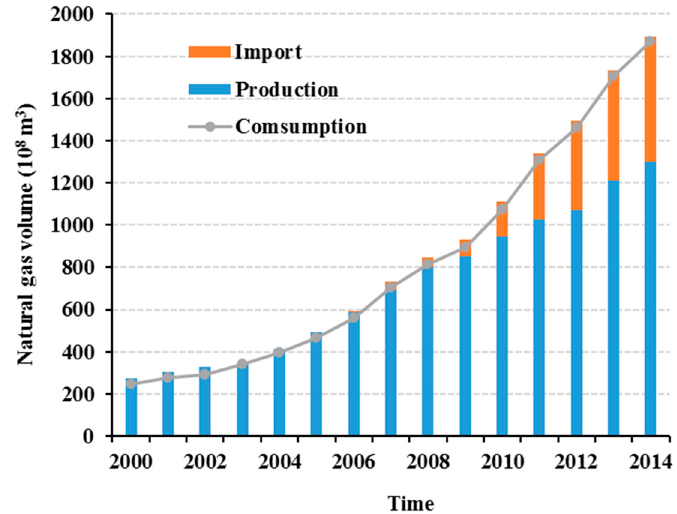
Figure 2. Natural gas import, production and consumption situation in China.